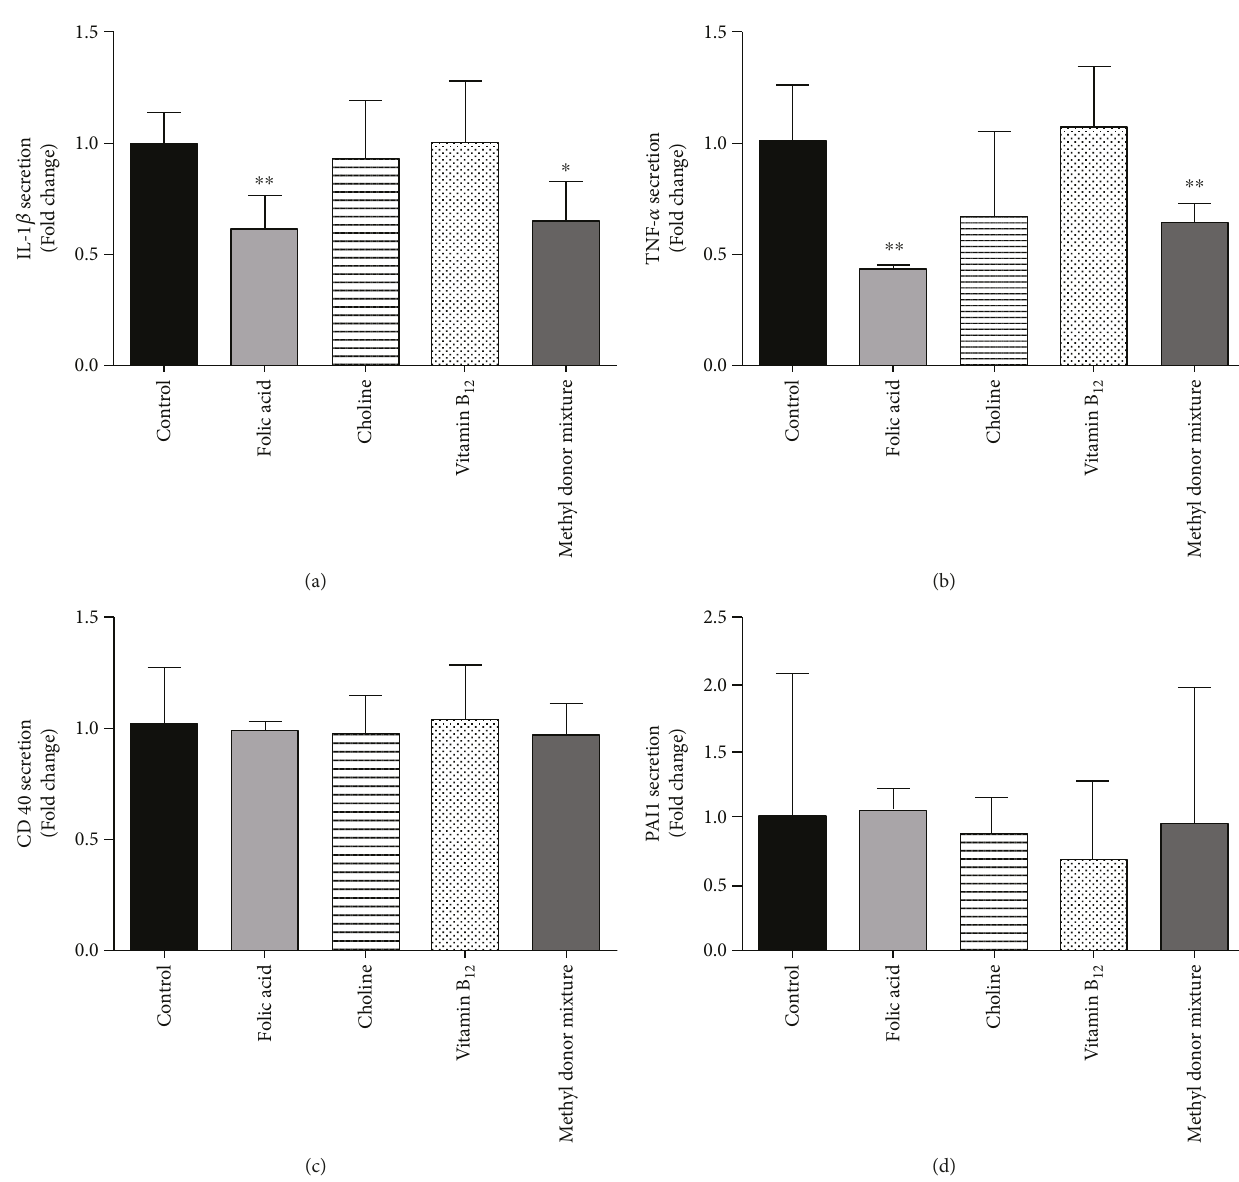
Figure 2: E ff ects of folic acid, choline, vitamin B , and the methyl donor mixture on the secretion of in fl ammatory cytokines in THP-1 cells 12 treated with TPA and LPS. (a) IL-1 β , (b) TNF- α , (c) CD40, and (d) PAI-1 secretion. Results are expressed as means ± SD ( n = 7 – 8 ). Di ff erences between groups were analyzed by one-way ANOVA followed by Dunnett ’ s test. ∗ P value < 0.05 and ∗∗ P value <